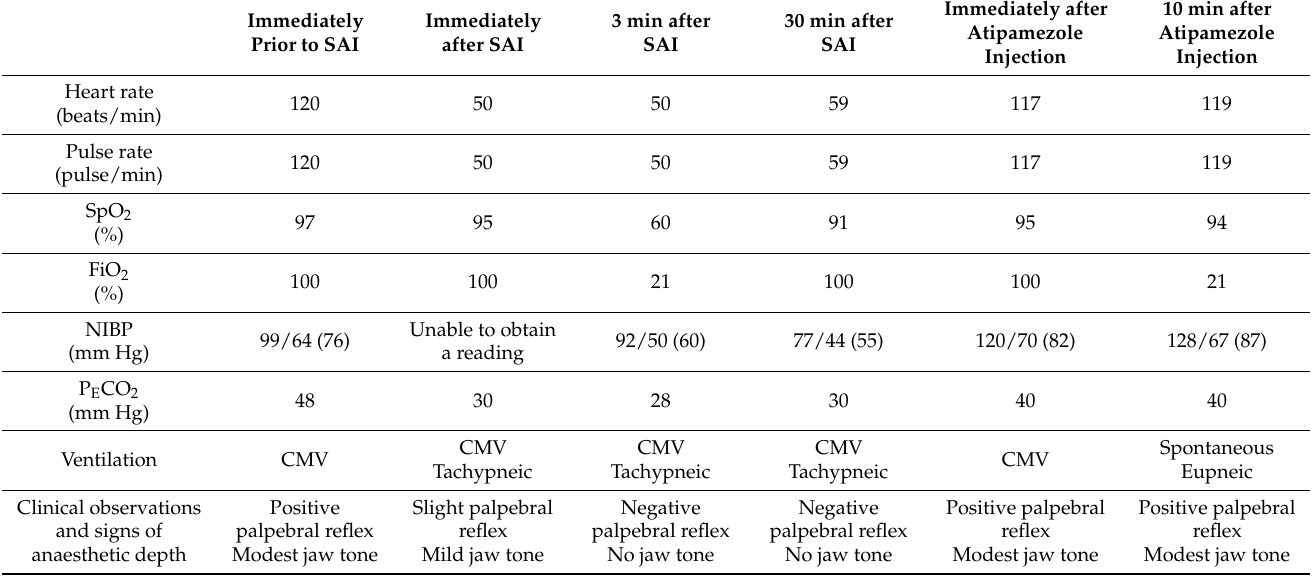
Table 1. Cardiorespiratory variables for an adult castrated male Merino sheep undergoing experi- mental spinal surgery prior to and following the subarachnoid injection (SAI) of xylazine 0.05 mg/kg at the lumbosacral site, and its antagonism 40 min later with high dose atipamezole 0.05 mg/kg intravenous